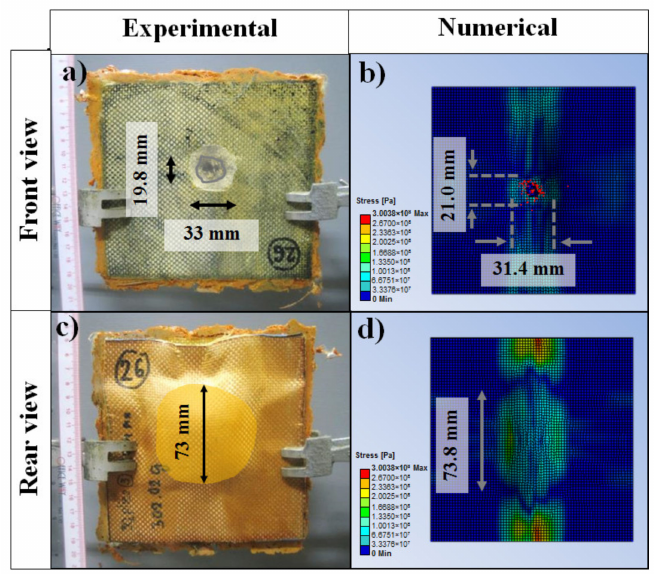
Figure 10. Comparison of damage areas as determined by ( a , c ) experiment or by ( b , d ) numerical simulation. See text for more details.